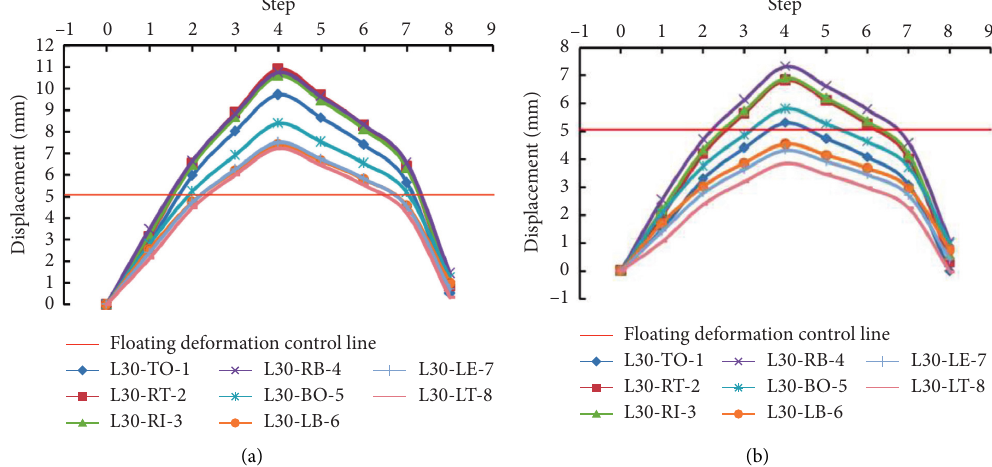
Figure 7: The vertical displacement of each monitoring points of each case when H / D is 3. (a) Working condition 1 ( I / D � 3) vertical displacement of monitoring point. (b) Working condition 5 ( I / D � 5) vertical displacement of monitoring point.